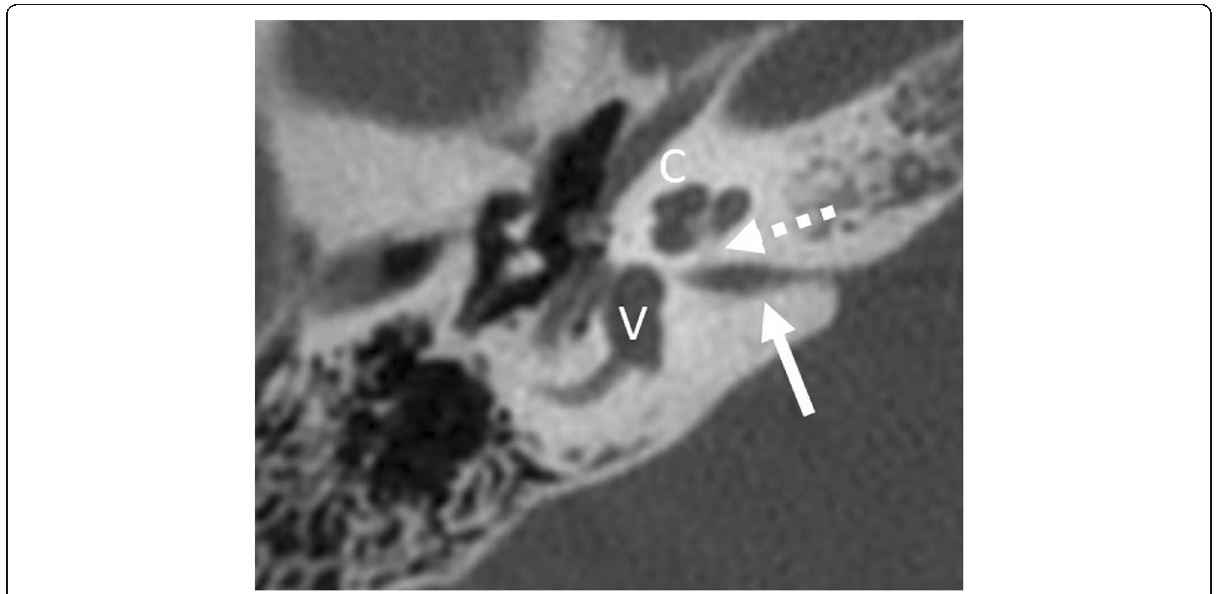
Fig. 14 A 16-year-old female patient, with unilateral deafness from birth. HRCT axial image shows high-grade stenotic bony cochlear nerve canal (dashed arrow) and the stenotic internal auditory canal (arrow). Cochlea (C) and vestibulum (V) appear